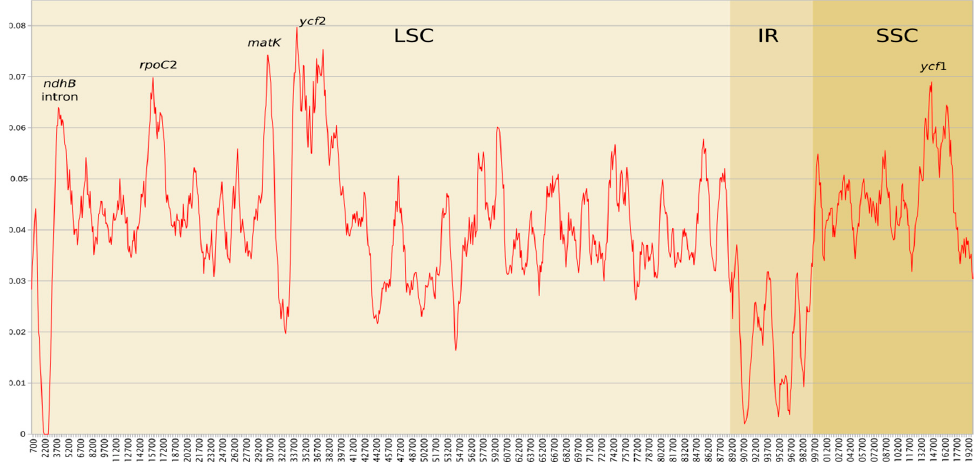
Figure 5. Nucleotide diversity (Pi) by sliding window analysis in the aligned whole plastomes (excluding second IR) of 14 Marchantiidae specimens. Window length 1000 bp, step size 100bp.